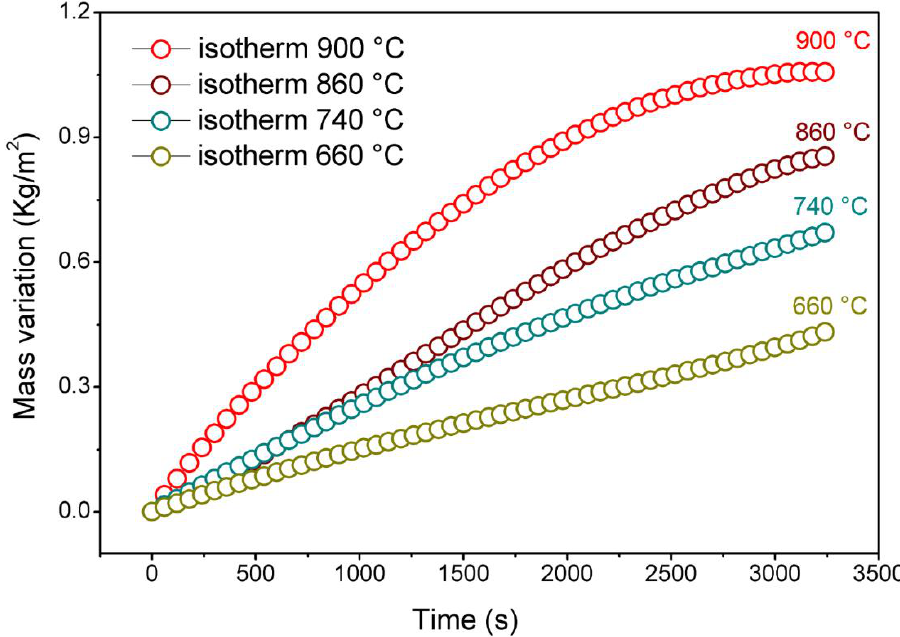
Figure 5. Mass variation per unit surface area as a function of the exposure time for the Ni-based alloy at 660, 740, 860, and 900 °C. alloy at 660, 740, 860, and 900 ◦